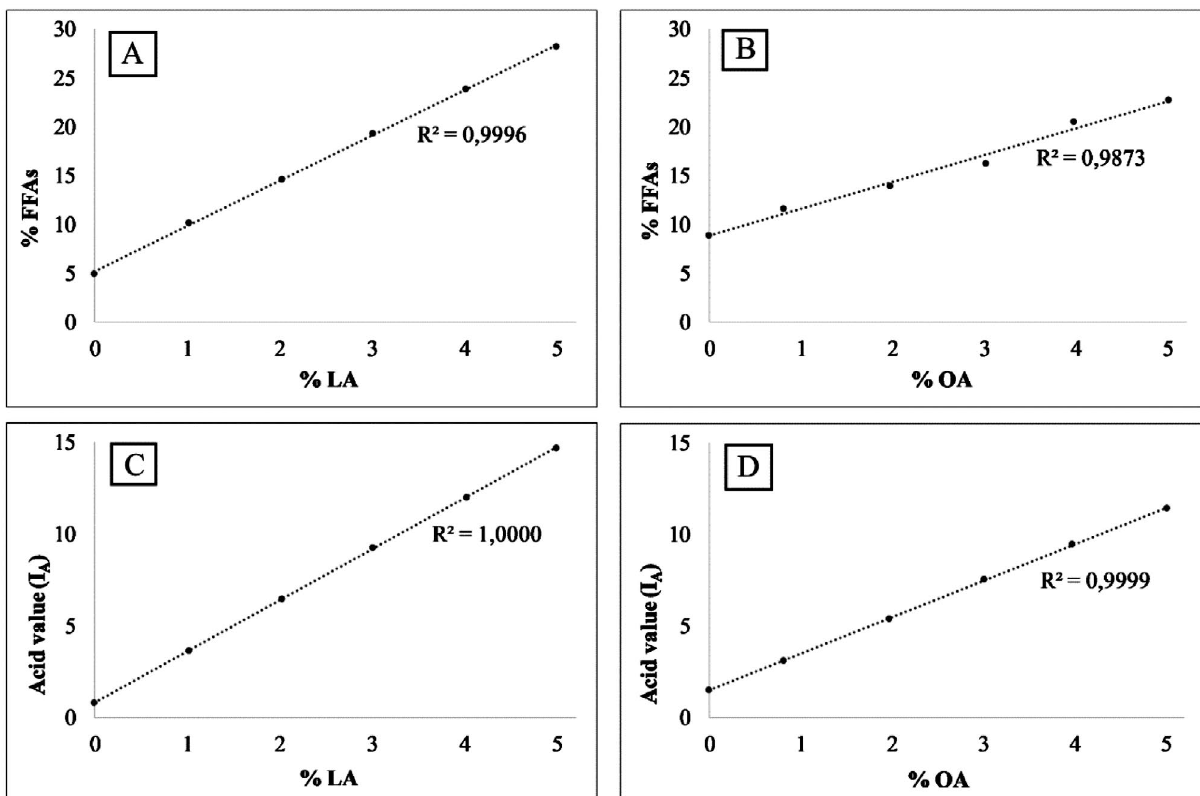
Fig 5. Values of % FFAs (n/n %) relative to % LA (w/w) in PS 20 (A), values of % FFAs (n/n) relative to % OA (w/w) in PS 80 (B), I A values relative to % LA (w/w) in PS 20 (C) and I A values relative to % OA (w/w) in PS 80 (D).